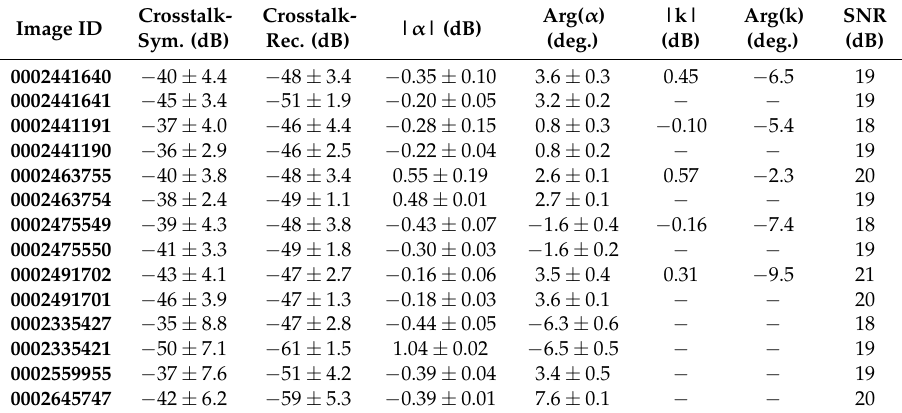
Table 3. Polarization distortion errors of the standard GF-3 images.